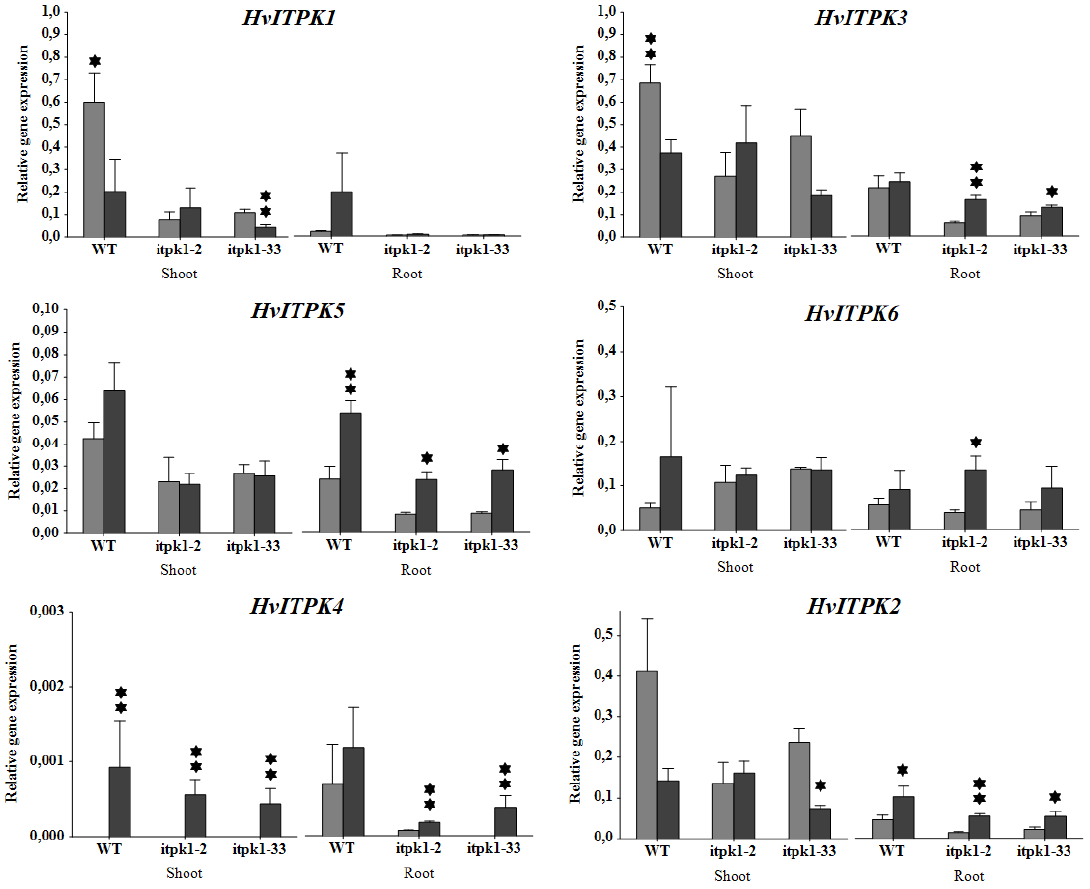
Figure 6. Relative transcript abundance of ITPK genes. Light grey – control condition (MS medium), black – salinity stress (200 mM NaCl). The values are means ± SD (n = 3). The asterisks denote significant differences in gene expression between control and stress conditions, for * at p < 0.05 and ** p < 0.01 based on the Aspin-Welsch unequal-variance t-test.